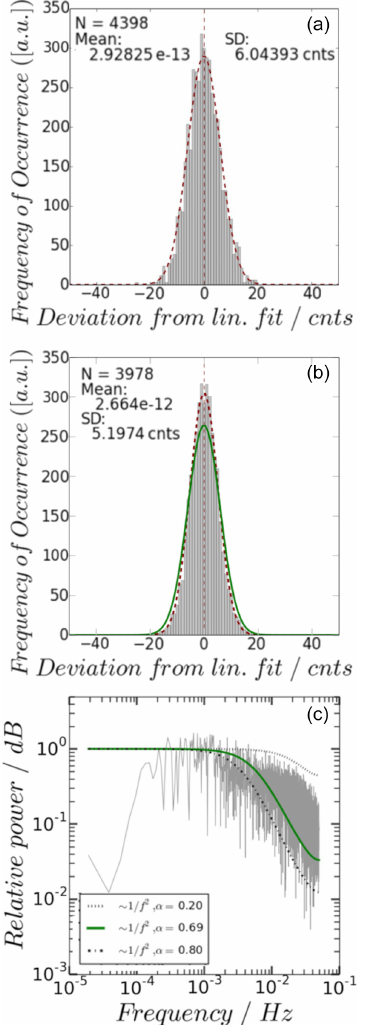
Figure 7. HALO MTP noise characteristics at 56.363GHz. Figures for the other two standard frequency channels look similar. Fit pa- rameters for all three frequency channels are summarized in Table 2. (a) Laboratory measurements in the cold chamber. Red dashed line: Gauss fit to the data. (b) Derived from ML CIRRUS flight data. Green line: ideal Gauss function with the mean at 0.0 and a standard deviation of 6 counts ( ∼ 0.25K), as implied by the cold-chamber noise spectrum. (c) Noise spectrum calculated from ML CIRRUS flight data. Black dashed lines: theoretical power spectra of 1 /f 2 noise with lag-1 correlations of α = 0 . 2 and α = 0 . 8. Green solid line: theoretical power spectrum of 1 /f 2 noise with lag-1 correla- tion of input